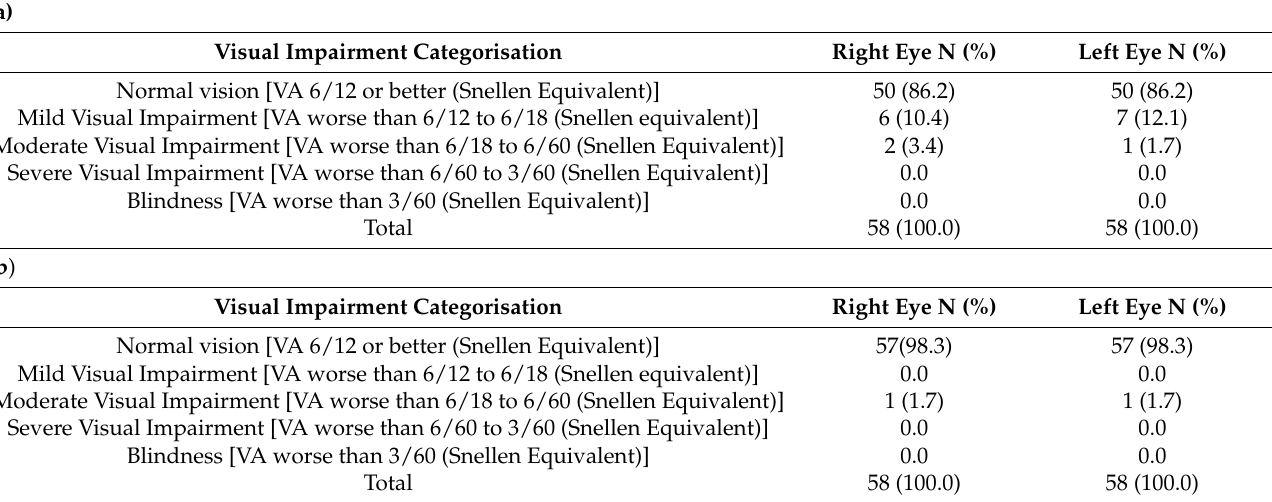
Table 1. ( a ) Distribution of subjects according to presenting visual acuity/impairment in children and adolescents with diabetes mellitus, N = 58. ( b ) Distribution of subjects according to best-corrected visual acuity/impairment in children and adolescents with diabetes mellitus N =